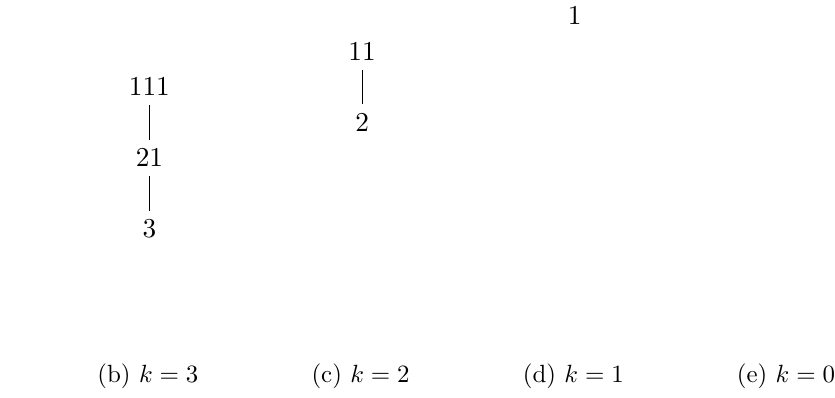
Figure 4. The partial Higgsing pattern for U( k ) with one adjoint and N = 1 fundamental hypermultiplet, for 4 ≥ k ≥ 0 . The partitions of k denote the residual gauge group.